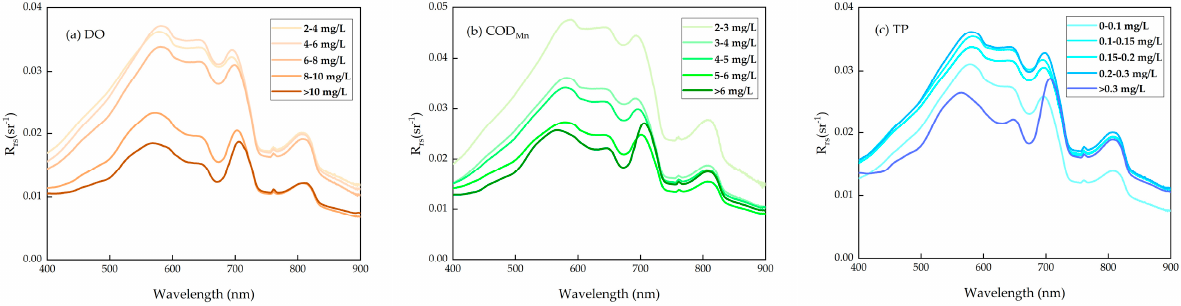
Figure 7. Average spectra of DO ( a ), COD Mn ( b ), and TP ( c ) in different concentration ranges.